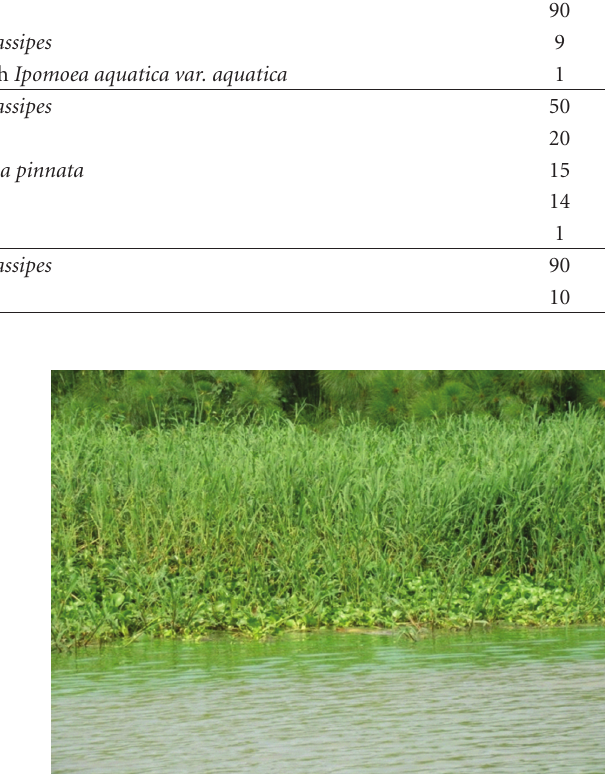
Figure 4: The late stages of macrophyte succession showing hip- pograss replacing the water hyacinth.